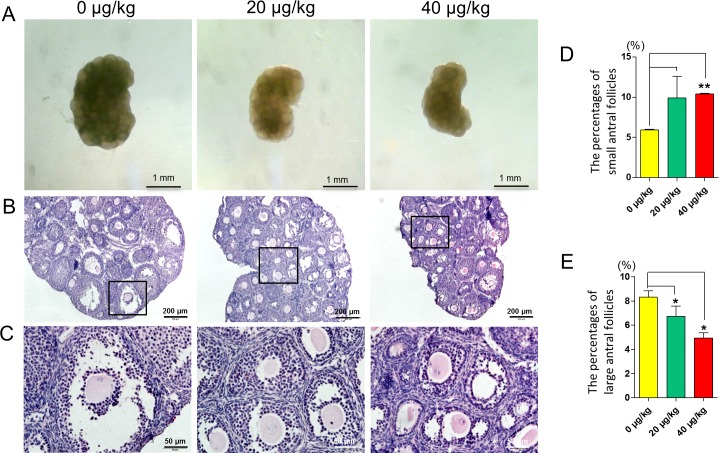
Effect of DEHP exposure on mouse ovaries.(A) Control and DEHP-treatment group of 20 dpp mouse ovarian morphology. (B-C) Control and DEHP-treatment groups of 20 dpp mouse ovarian HE histochemical sections. (D) The percentages of small antral follicles in the control and DEHP-treatment groups. (E) The percentages of large antral follicles in the control and DEHP-treatment groups. Compared to the control group the percentage of each group was presented as mean ± SD. All experiments were repeated at least three times independently. (* P < 0.05; ** P < 0.01).